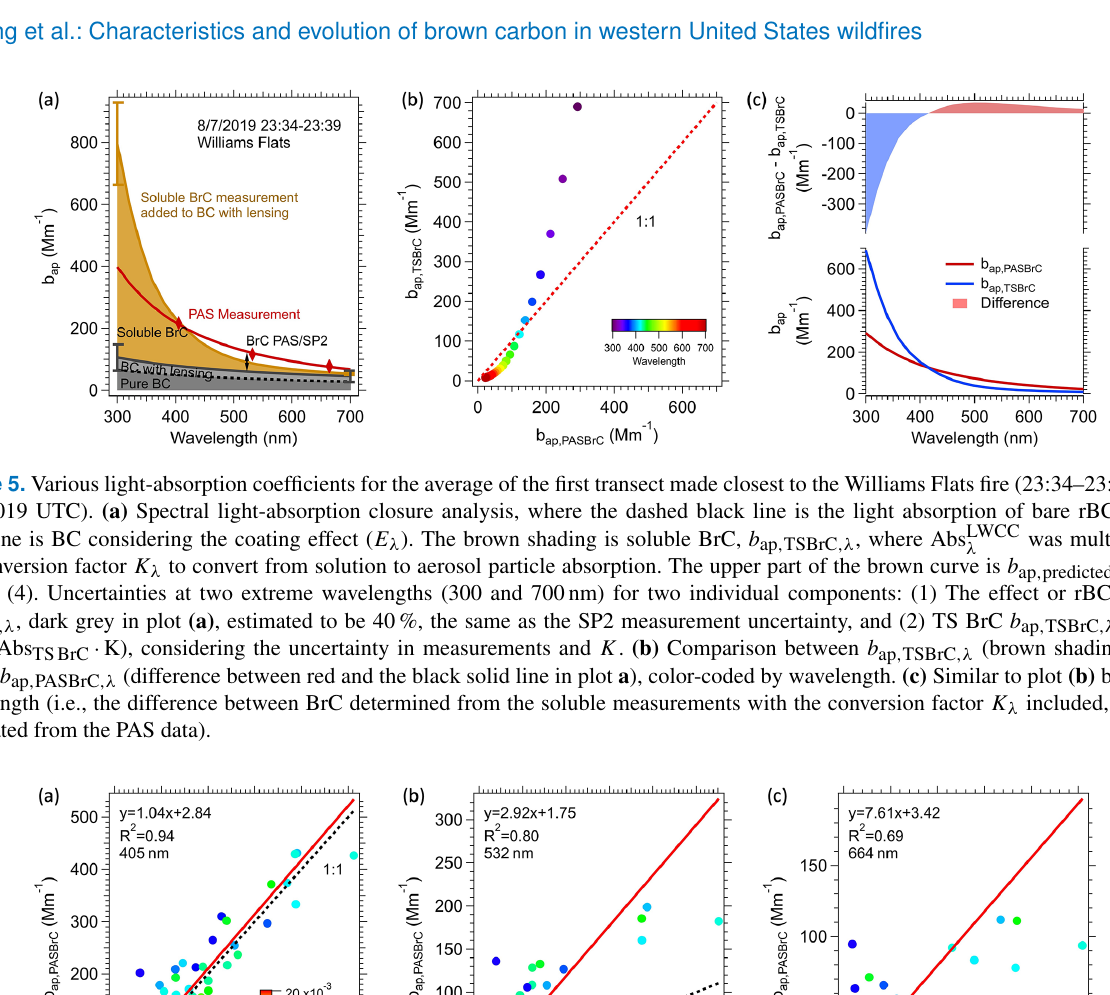
Figure 6. Comparisons between BrC inferred from the PAS ( b ap , PASBrC ,λ ) and total soluble BrC converted to aerosol absorption ( b ap , TSBrC ,λ ) at (a) 405nm, (b) 532nm and (c) 664nm, color-coded by rBC / OA ratio. The red line is fitted via orthogonal distance regression (ODR). In all plots, the dotted black line shows a slope of